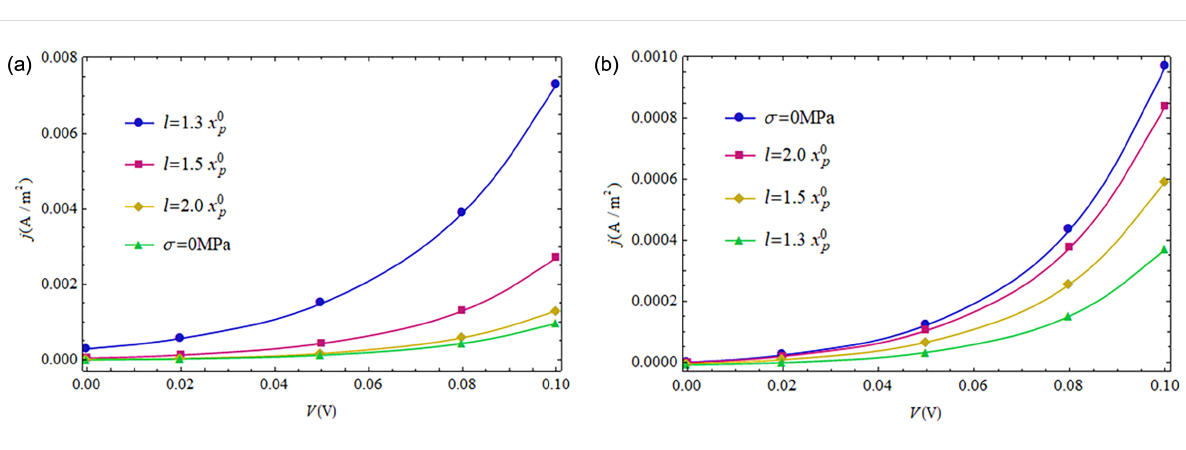
will be redistributed to induce an additional electric field, which in turn has a weakening effect on the polarization electric